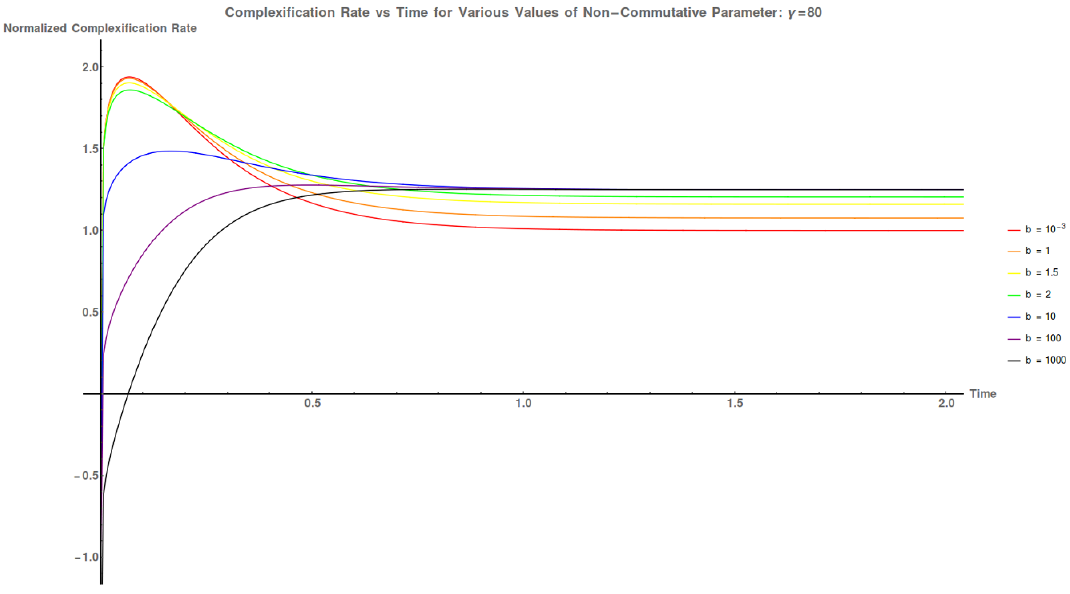
Figure 5 . Normalized complexi(cid:12)cation rate versus time in thermal units. (cid:13) is held (cid:12)xed at 80 while b = ar H is